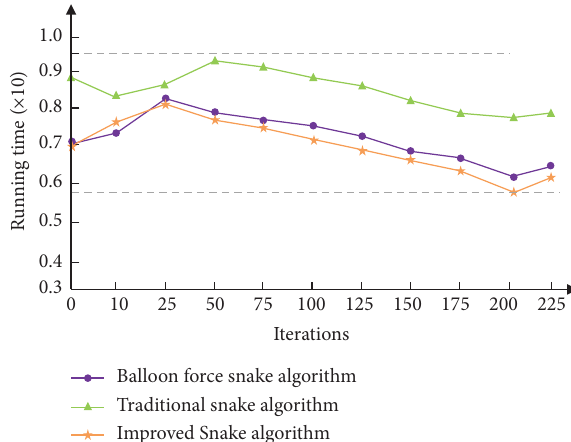
Figure 7: Te relationship between the running time required for diferent algorithms to reach the temperature stability state and the number of iterations.